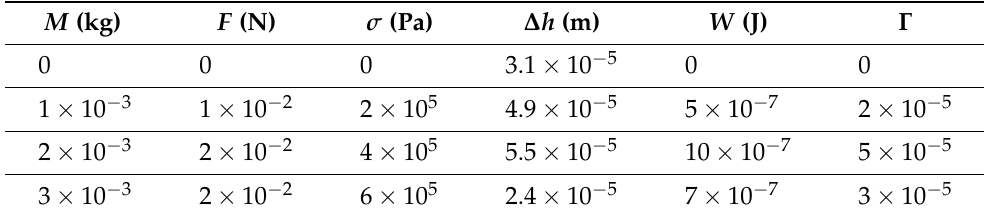
Table 3. Data for photowork and